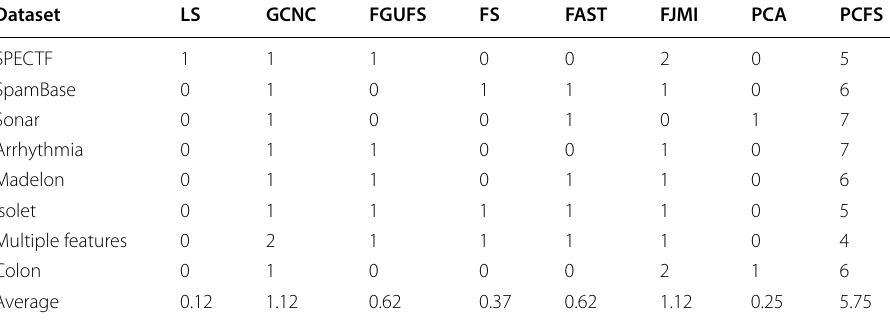
Table 4 Number of times different methods achieve the best results with NB classifier